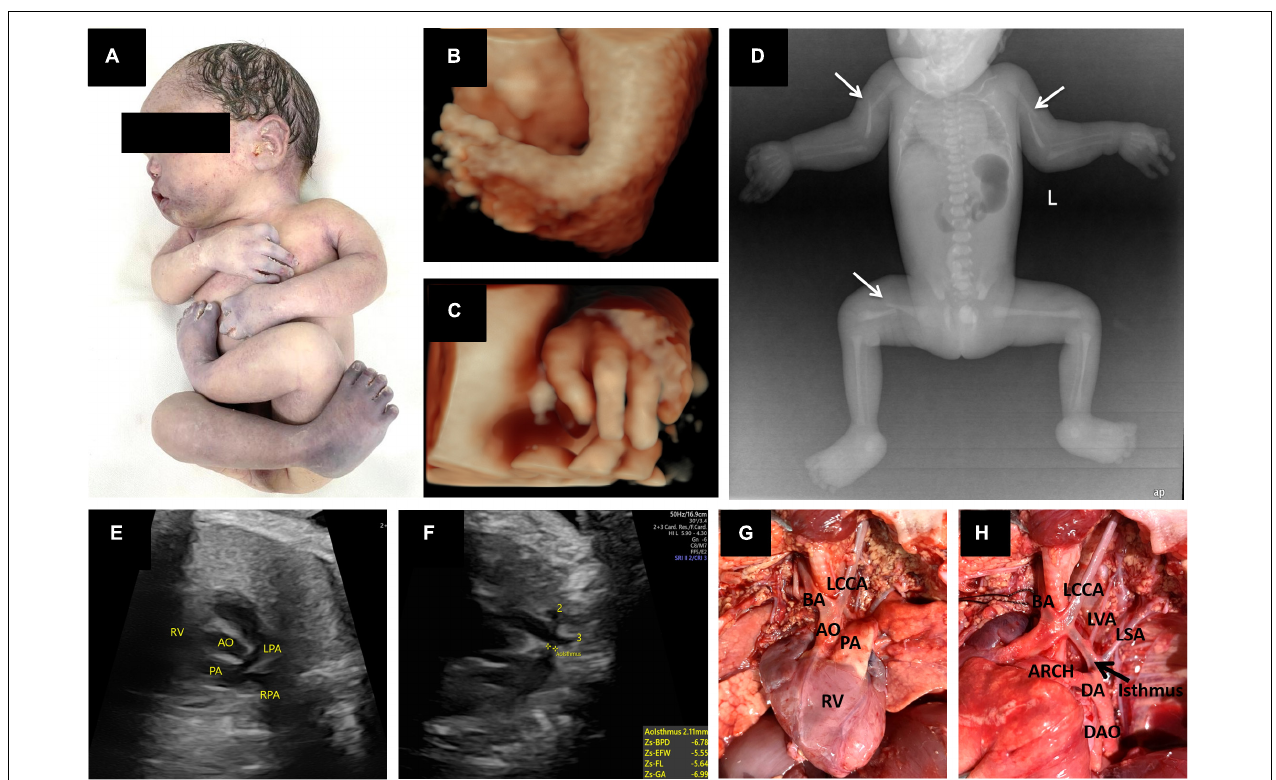
FIGURE 2 | Prenatal 3D ultrasound images and fetal echocardiography, postpartum gross anatomical specimens, X-ray photographs and cardiac anatomy. (A) Postmortem photo demonstrated multiple contractures of the upper and lower extremities. (B,C) Three-dimensional ultrasound showed fetal foot inversion and tilted fingers. (D) X-rays showed bilateral humerus and right femur fractures (thin white arrow). (E,F) Prenatal echocardiography showed a right ventricular double outlet with coarctation of the aortic arch. (G,H) Postpartum cardiac anatomy confirmed sonographic findings. In addition, there were four arteries of the aortic arch, from right to left: BA, the brachiocephalic artery; LCCA, the left common carotid artery; LVA, the left vertebral artery; and LSA, the left subclavian artery. RV, right ventricle; AO, aorta; PA, pulmonary artery; LPA, left pulmonary artery; RPA, right pulmonary artery; DA, ductus arteriosus; DAO, descending aorta; ARCH, aortic arch.